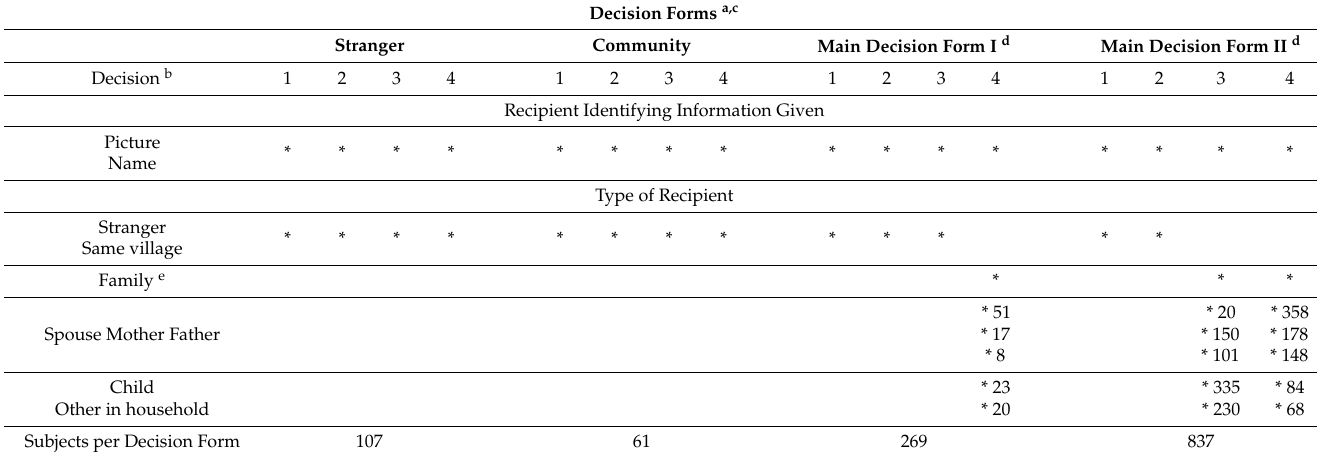
Table A1. Decision forms